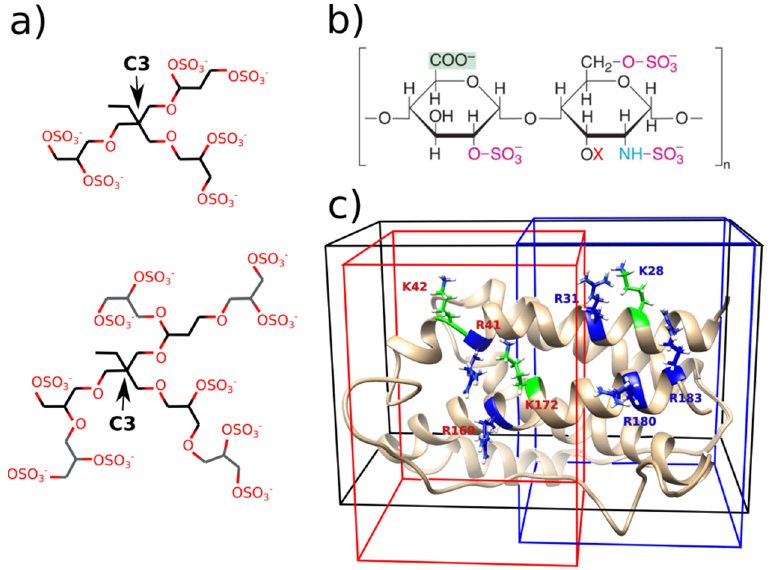
Figure 1. ( a ) Sketch of the first and the second generation of the dPGS. Gray colored carbons are additional branches that mark the second generation. Indicated C3 atom is used in the analysis of the MD simulations; ( b ) Structure of the heparin disaccharide unit, red X marks the variably sulphated position, which means that X=H or SO 3 − . ( c ) Structure of hIL-6 with the highlighted amino acids used to define the binding sites and the corresponding docking boxes. Red labels and red colored box for RKRK site, and blue labels, blue colored box for KRRR site. Black box includes both binding sites RKRK&KRRR. Structures are not up to scale. Table 1. Summary of the binding affinities of the most favorable docking positions of ligands to hIL-6. For each ligand number of bonds that were rotated during the docking is